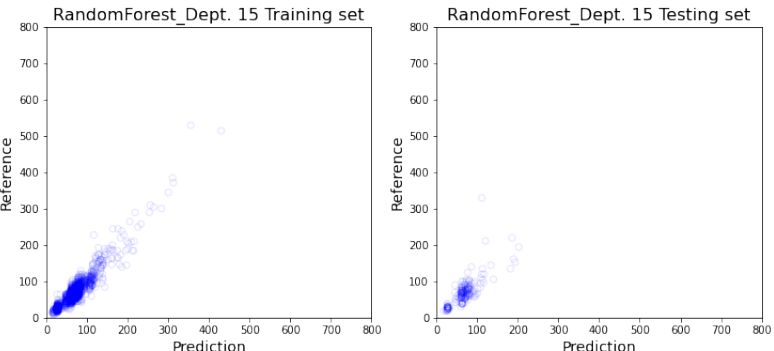
Figure A10. Model Performance of RandomForest on Dept.15. The visualization of training and testing data for department specific model on department 15 with Random Forest.